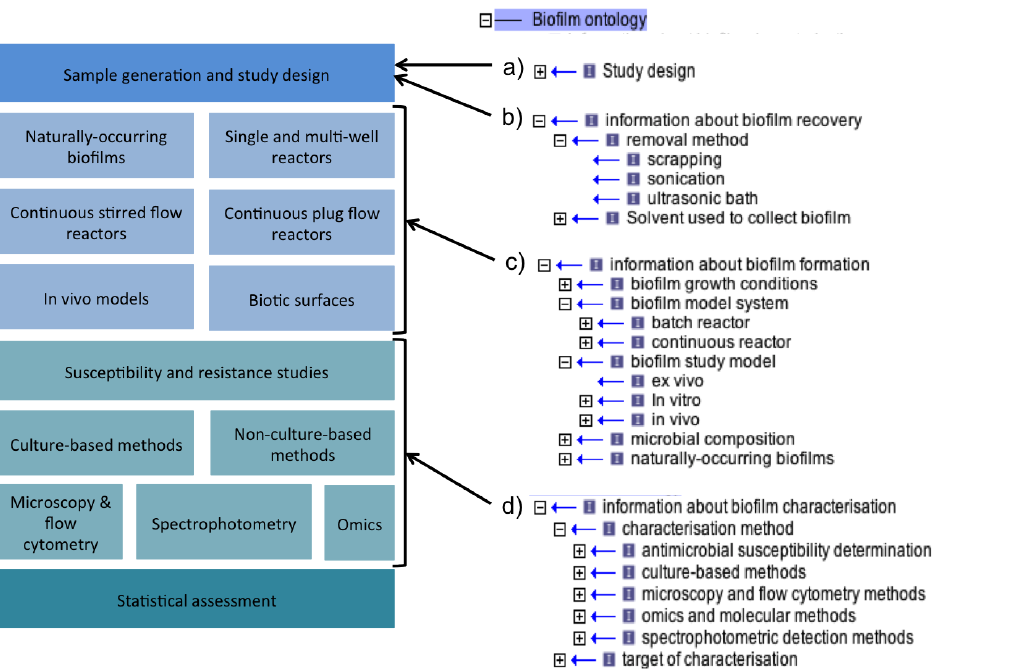
Figure 2: The structure of the Biofilms ontology. The top-level branches (right side of the figure) are in compliance with the basic modules of information proposed by the MIABiE initiative (left side of the